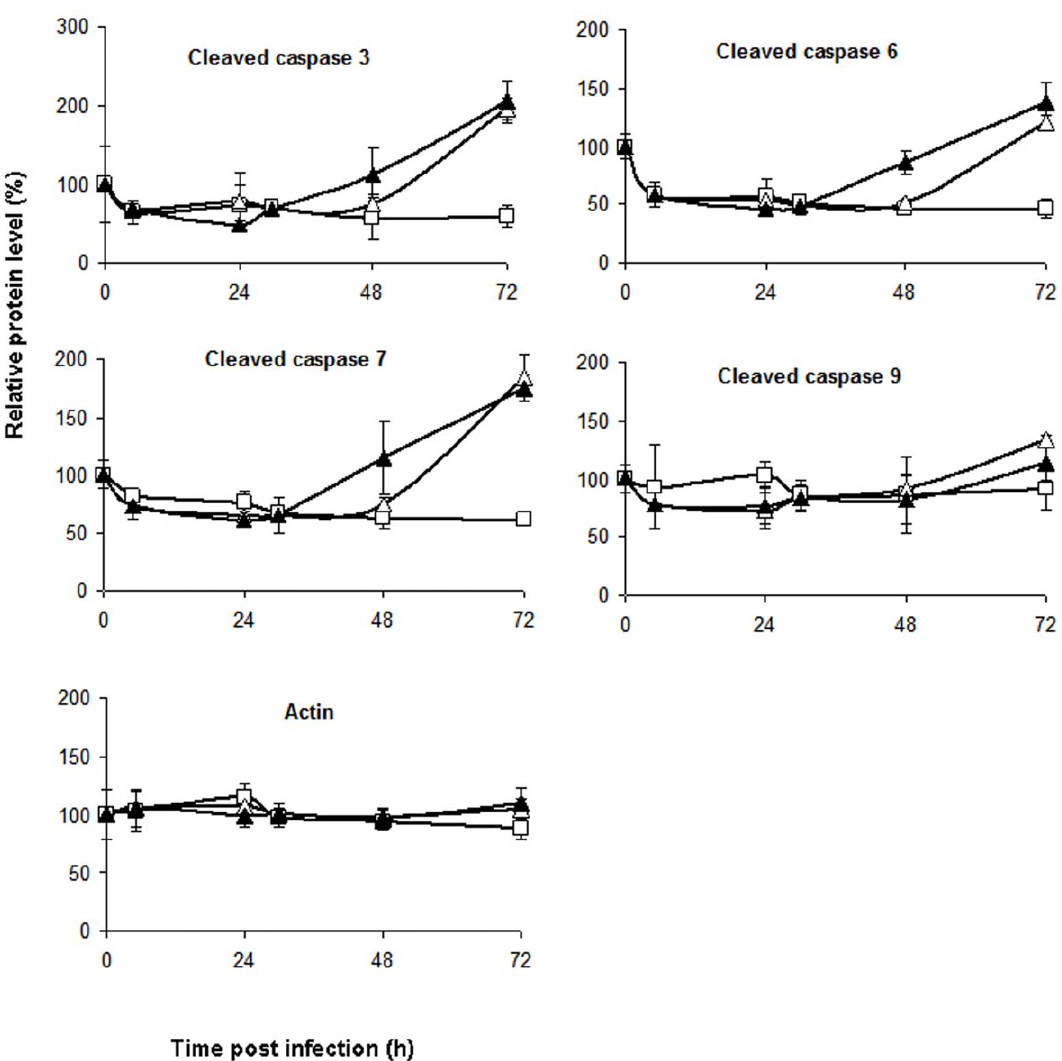
Figure 6. RPMA data for caspase-3, -6, -7, and -9 and actin. X axis labels, time post infection (h.p.i); Y axis labels, protein level relative to untreated cells (%) at 0 h.p.i. Open triangles, closed triangles and open squares correspond to the low MOI, high MOI and uninfected cells, respectively. Data represent mean values and confidence intervals of two-tail t-test ( a =0.05, n =3).